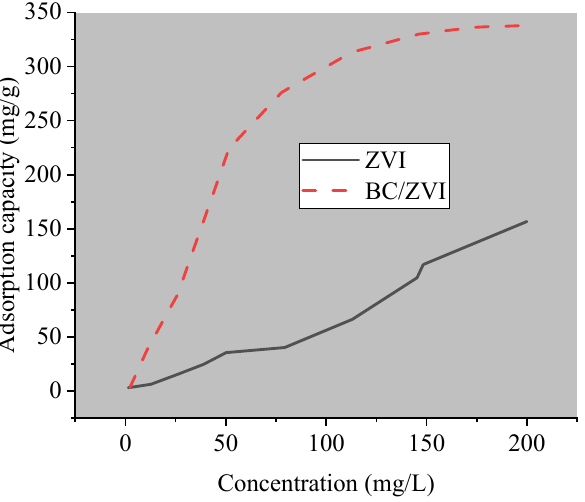
Figure 5. TC removal effect of ZVI and BC/ZVI composites at different concentrations.